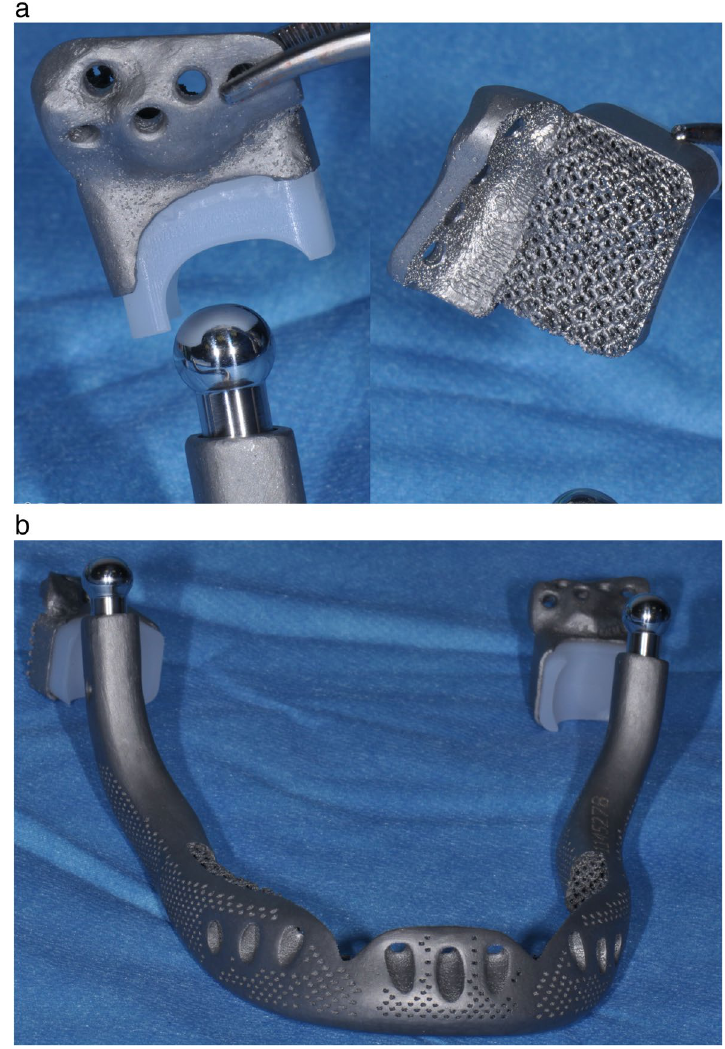
Fig. 3 a TMJ prostheses: condylar and cranial components, note the porous cranial surface. b The whole implant provided of condylar heads on the surgical